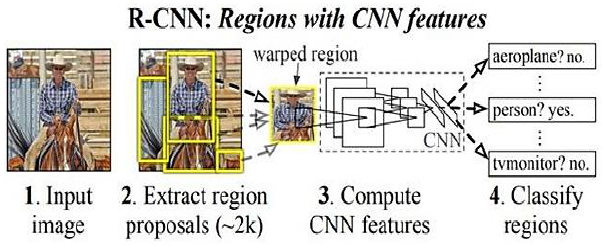
Figure 1. Selected search process in R-CNN [36].